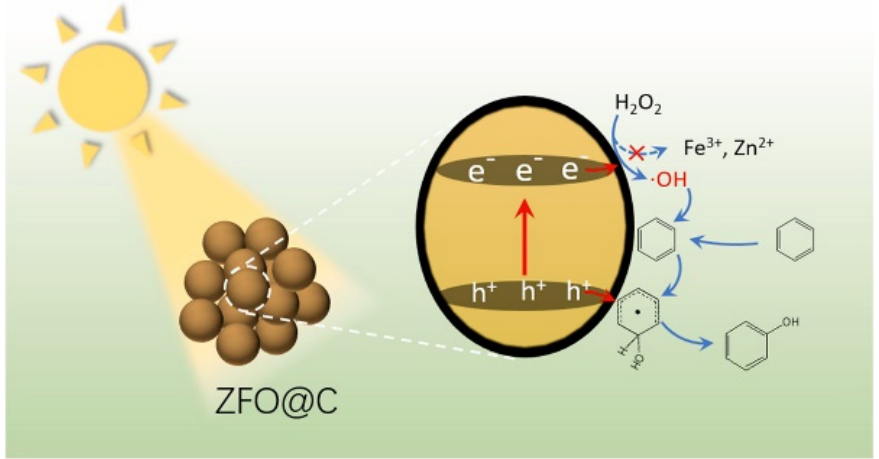
Figure 7. Photocatalytic hydroxylation of benzene to phenol over ZFO@C. Reprinted with permission from ref. [95] . 2022 Elsevier.